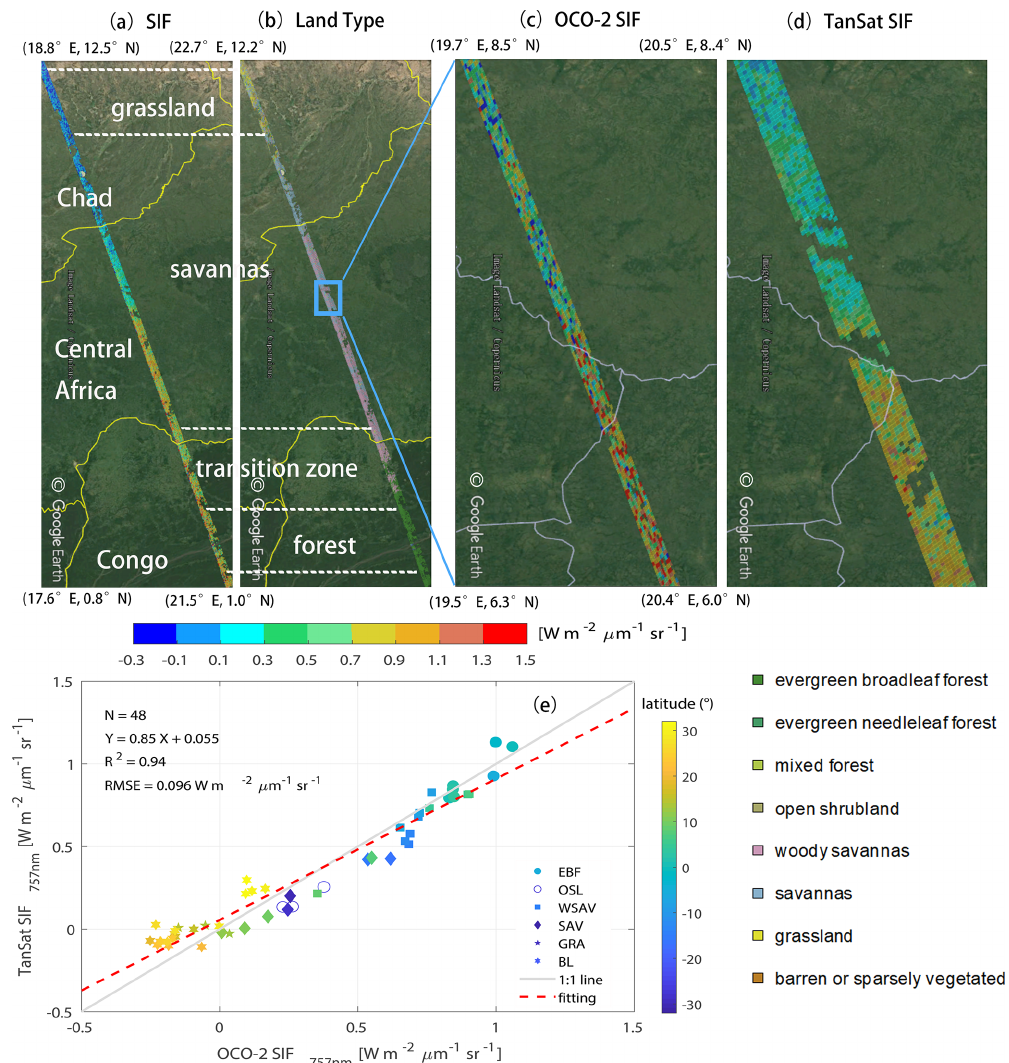
Figure 3. Overlapping orbits of TanSat and OCO-2 on 19 April 2017 over Africa displayed in © Google Earth: (a) the SIF measurements from both satellites and (b) the footprint land cover type were compared. Compared to OCO-2, TanSat has a wider swath width. A zoomed-in view of the savannas shows variations in the SIF signal measured by (c) OCO-2 and (d) TanSat. The land surface image shown in Google Earth is provided by Landsat/Copernicus team. Following the International Geosphere-Biosphere Programme classification scheme, the vertical legend on the bottom right corner depicts the land cover type that occurs in the study area. The middle horizontal color bar represents the intensity of the SIF radiance. (e) Small-area SIF comparison between OCO-2 and TanSat; each data point represents the mean SIF of a degree in latitude (colors) along the track. The marker legend that is shown on the bottom right of the plot indicates the dominant land cover (defined as the majority land cover type of each sounding) in each small area. There are six land cover types including evergreen broadleaf forest (EBF), open shrubland (OSL), woody savanna (WSAV), savanna (SAV), grassland (GRA), and barren land (BL). The red dashed line represents the linear fit between the two SIF products with statistics shown in the upper left of the plot. The gray line indicates a 1:1 relationship for